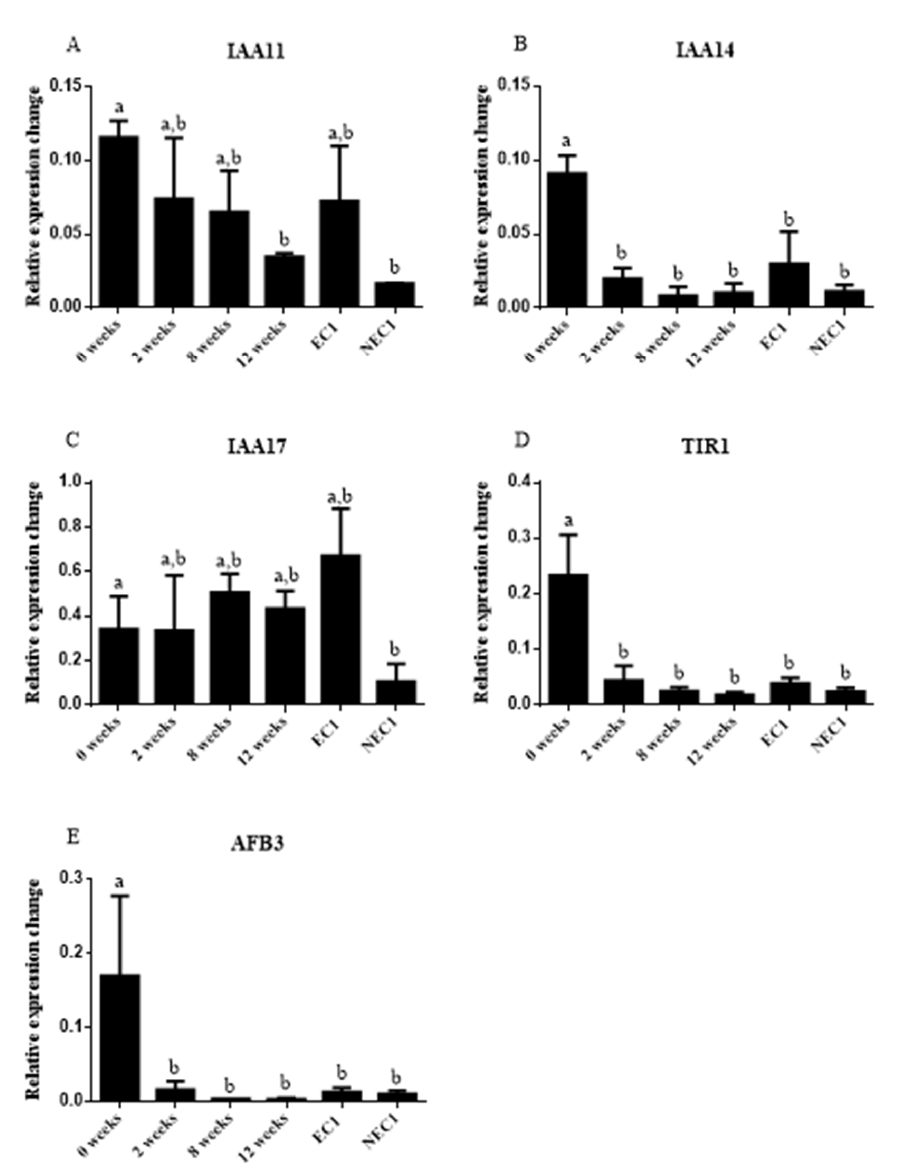
Figure 5. Relative gene expression. Relative expression was calculated in relation to reference genes previously validated for tamarillo. Results are presented as mean ± SD. Different letters are significantly different according to Tukey test ( p < 0.05).